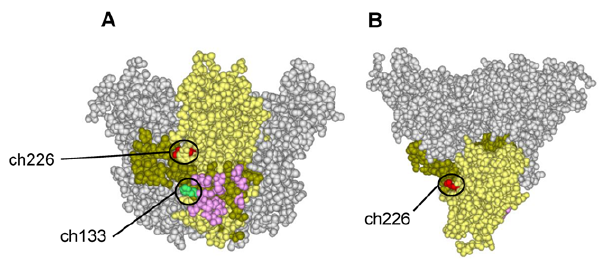
based on the crystal structure of ZEBOV GP (PDB code: 3CSY). This structure lacks amino acid residues at positions 190–213, 311–312, 464– 501, and 600–632, because no electron density was observed for these residues [16]. The molecular surfaces of the GP trimer are shown in side (A) and top (B) views. While one monomer is depicted as both subunits, GP1 (yellow) and GP2 (brown), the other two monomers are colored gray. The amino acid residues identified in escape mutants at positions 134 (ZGP226/8.1; ch226) and 549 (ZGP133/3.16; ch133) are shown in red and green, respectively. The epitope recognized by MAb KZ52 in the crystal structure of the GP-MAb complex is highlighted in pink.